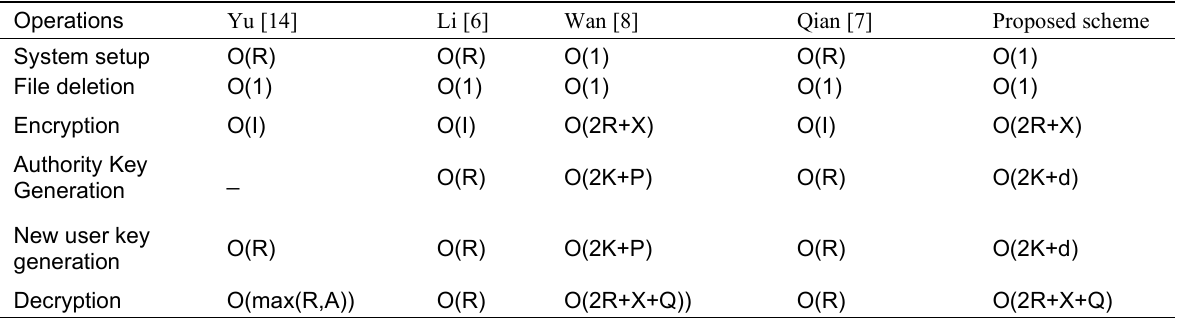
Table 2. Comparison of computational